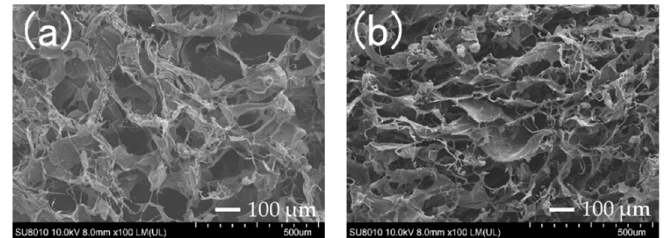
Figure 2. Scanning Electron Microscopy (SEM) photographs of sponges (( a ): collagen (COL) and ( b ): nano-hydroxyapatite/collagen (nHAP/COL)) prior to hydraulic press at low magnification (×100).